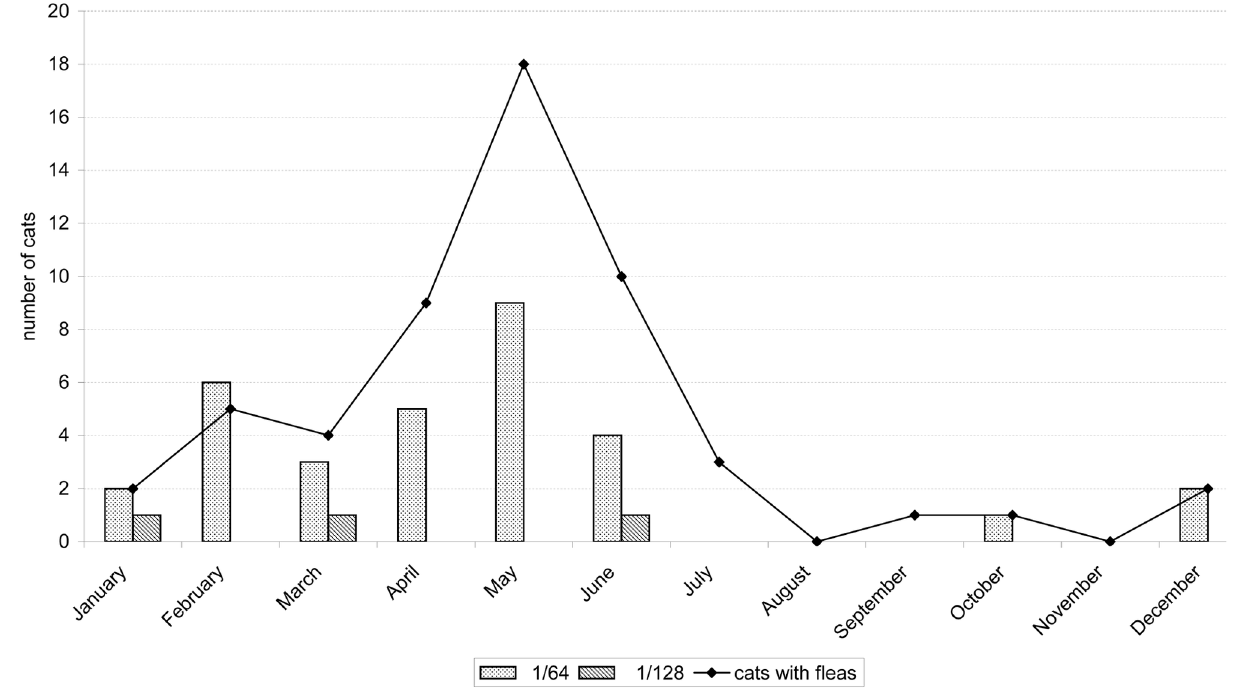
Figure 3. Annual distribution of infested animals and titres obtained by indirect immunofluorescence antibody assay.